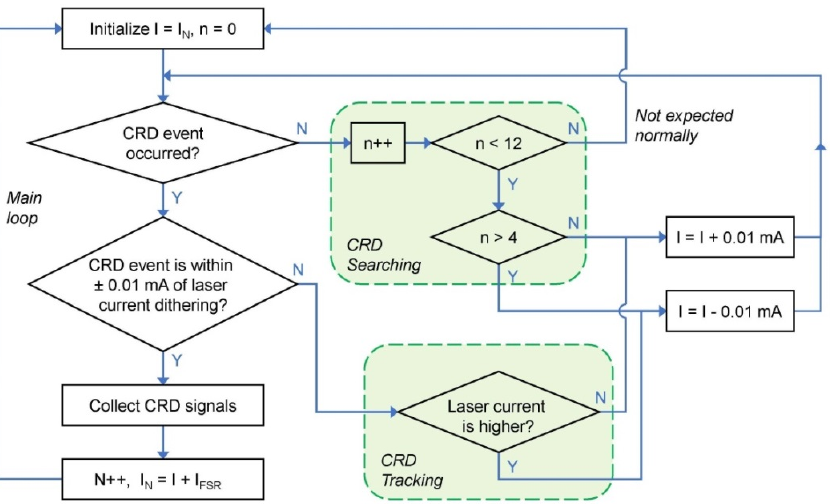
Figure 3. Flowchart of the control scheme for searching, tracking, and step-scanning the laser wavelength to match optical cavity resonances.